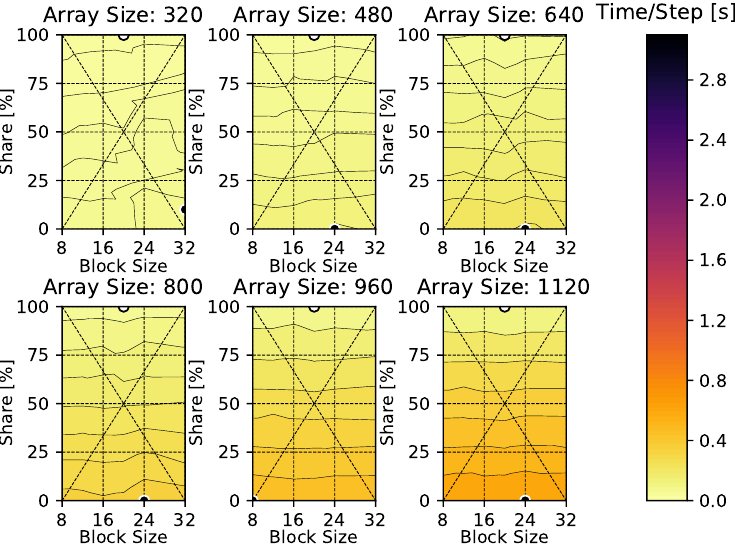
Figure A4. Heat equation time per timestep performance using Standard solver with Intel Skylake Silver 4114 CPUs and GeForce GTX 1080 Ti